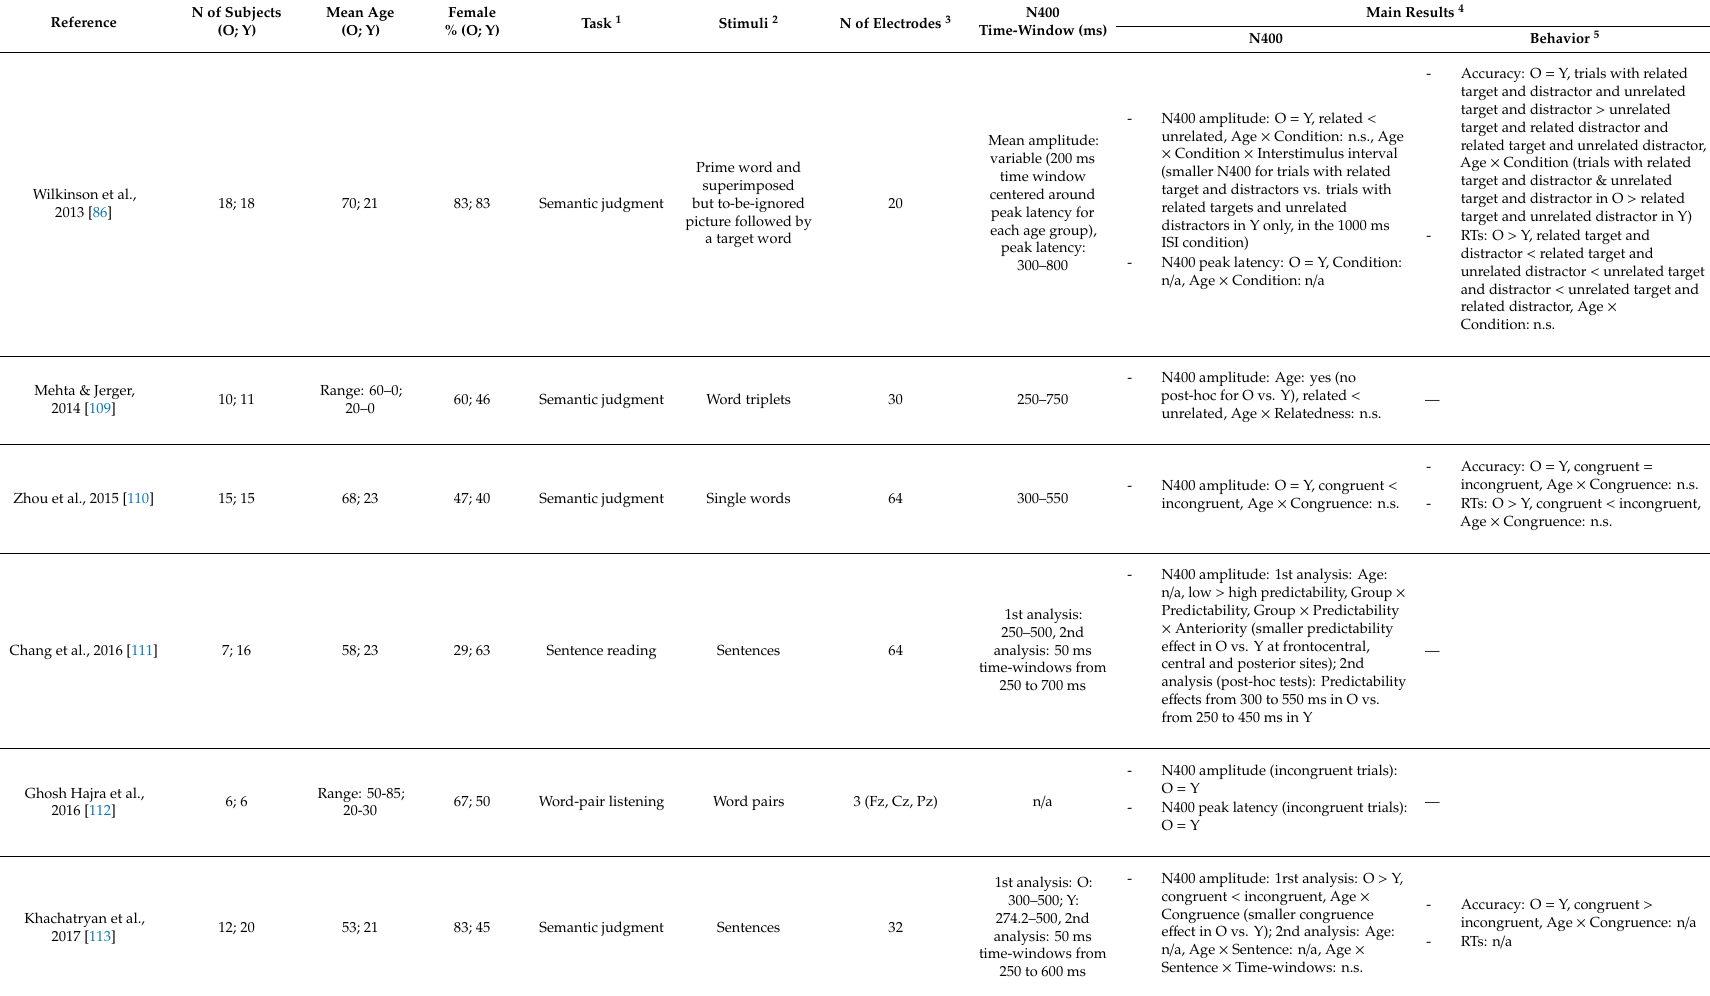
relateddistractor,Age × Condition:n.s.